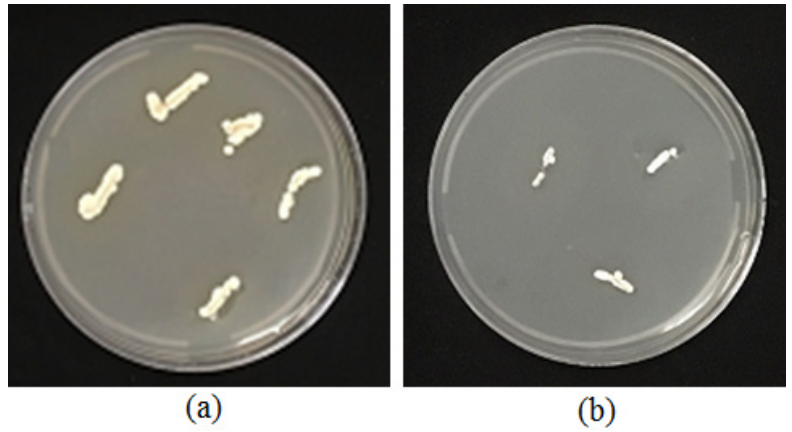
Figure 5. Result of root colonization of tomato seedling roots by two actinobacteria isolates, R7 and F8. ( a , b ) show colonies formed from aseptic transfer of cut roots of R7 and F8 treatment on CGA medium, respectively.